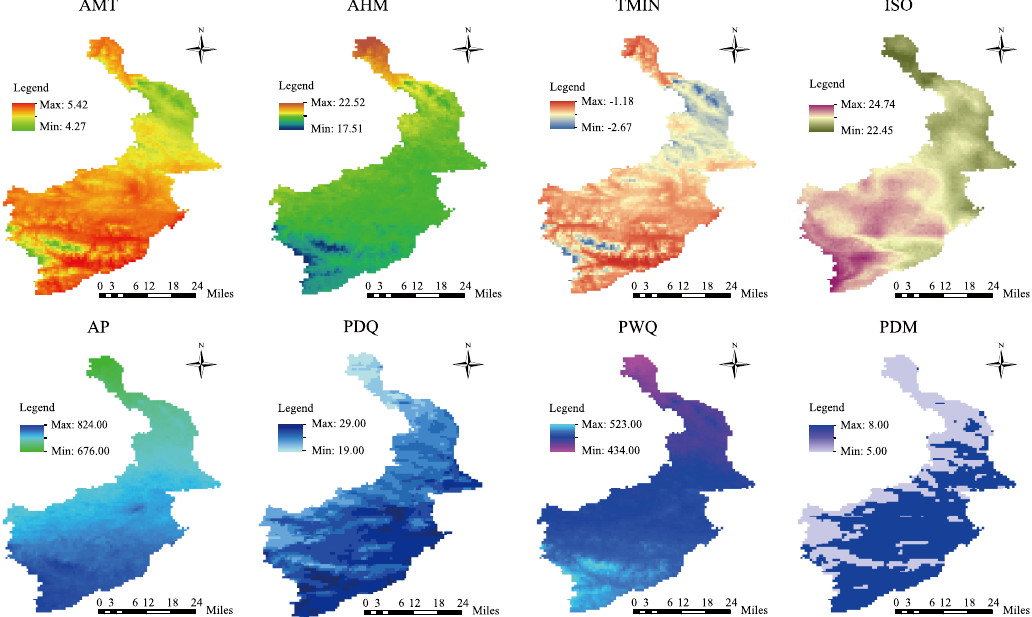
Figure 3. The information on climate variables in the study area. AMT, AHM, TMIN, ISO, AP, PDQ, PWQ, and PDM are annual mean temperature, annual heat moisture, minimum temperature, isothermality, annual precipitation, precipitation of driest quarter, precipitation of wettest quarter, and precipitation of driest month, respectively.